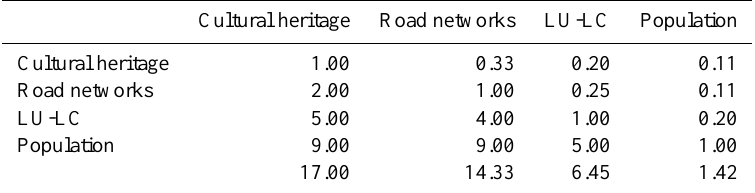
Table 7. Comparison matrix of socio-economic variables.